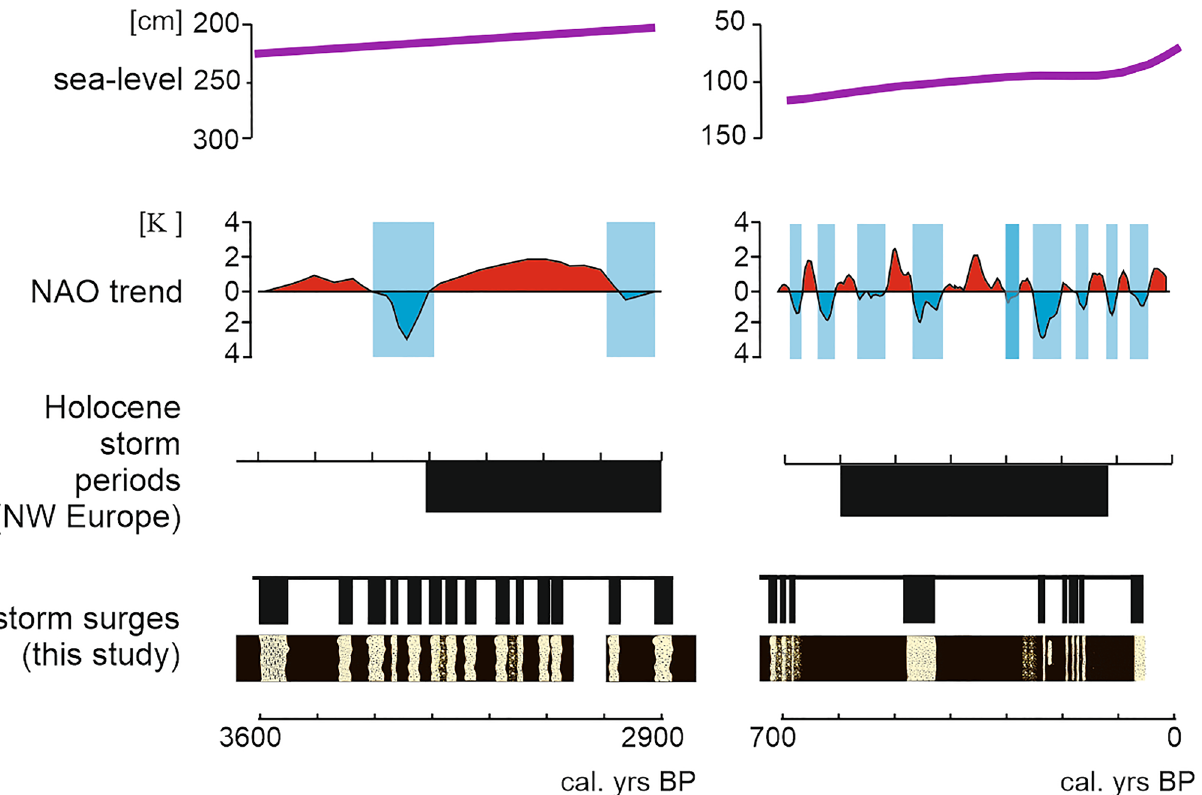
Figure 6. Comparison of the storm surge flooding controlling factors within the two studied time periods. Data sources: sea level trend based on 16,17 , NAO trend 3.6–2.9 ka BP based on 43 and 0.7 ka BP until present based on 46 , Holocene storm periods in northwestern Europe based on 40 . Figure was created with